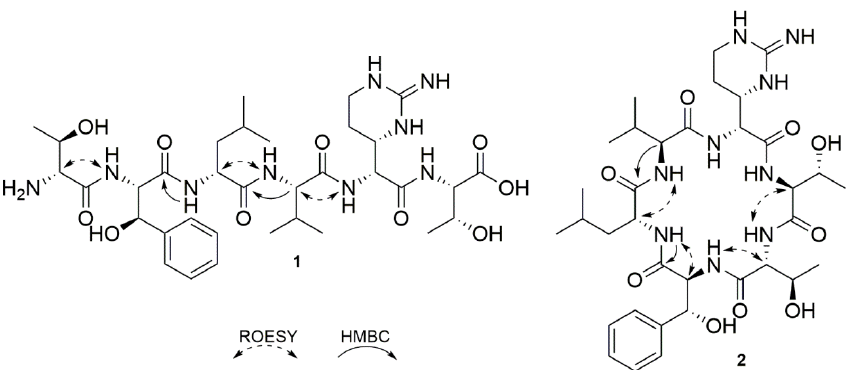
Figure 2. Structures of iso-faulknamycin ( 1 ) and cyclofaulknamycin ( 2 ) showing key HMBC and ROESY correlations.